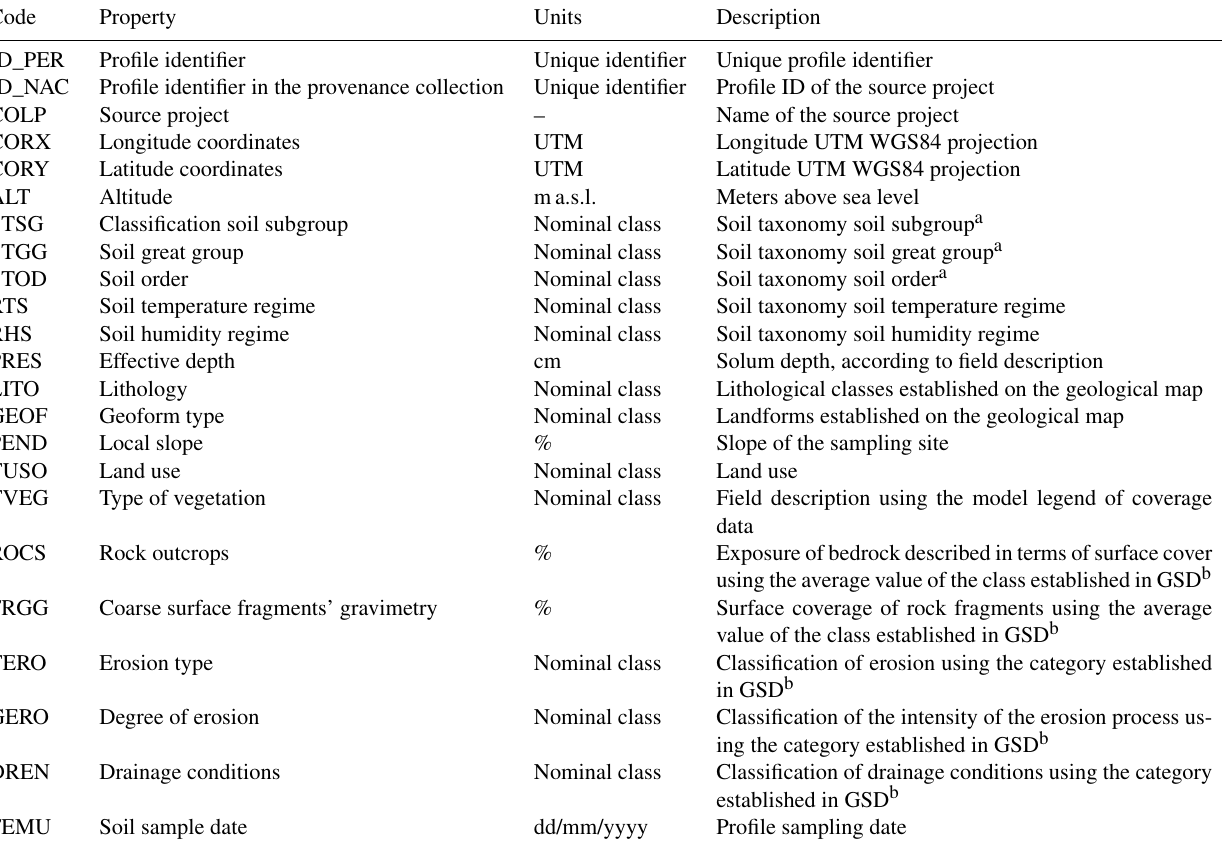
Table 1. The HESD profile variable names, codes, descriptions, and units.